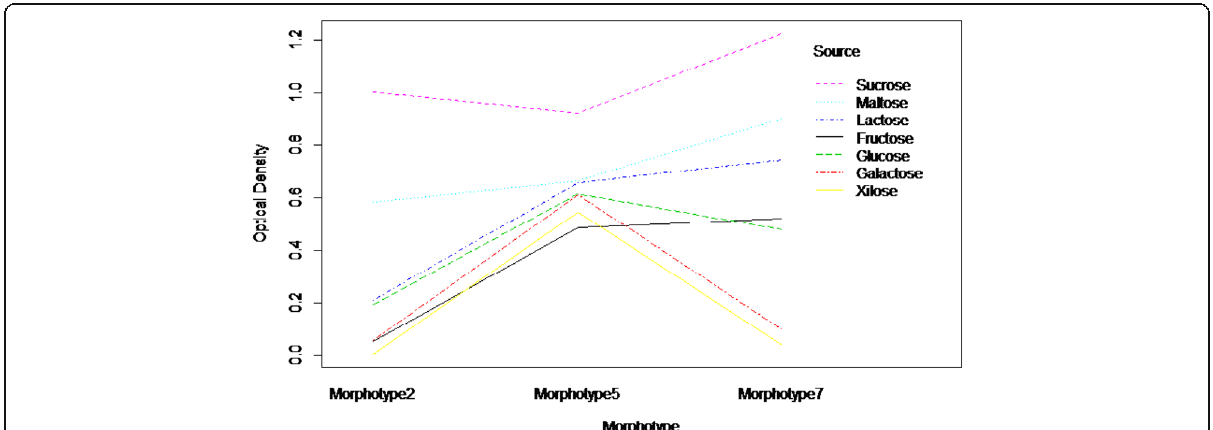
Fig. 5 Growth of antagonistic yeast morphotypes: M2, M5 and M7, using different carbon sources. Growth was measured by optical density at 540 nm after 48 h under the evaluated source. The two-way ANOVA indicated highly significant effects for carbon source ( F = 15.557; P < 0.05; df = 6) and morphotype ( F = 13.488; P < 0.05; df = 2) and a significant interaction effect ( F = 2.032; P = 0.0452; df = 12)